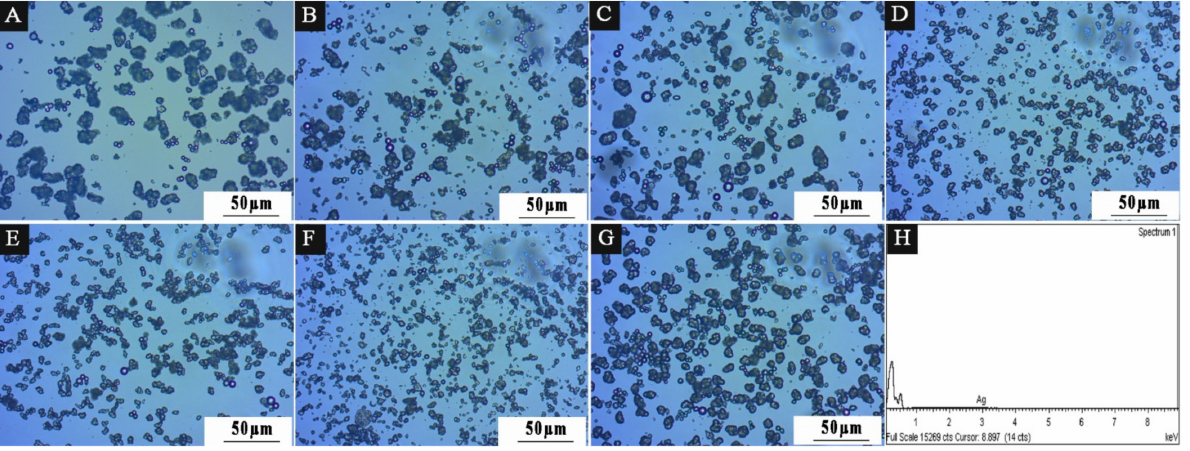
Figure 11. OM diagram of 7 groups of microcapsules in single-factor experiment: ( A ) 1 (cid:48) #, ( B ) 2 (cid:48) #, ( C ) 3 (cid:48) #, ( D ) 4 (cid:48) #, ( E ) 5 (cid:48) #, ( F ) 6 (cid:48) #, ( G ) 7 (cid:48) #, ( H ) EDS energy spectrum of 2 (cid:48) #.